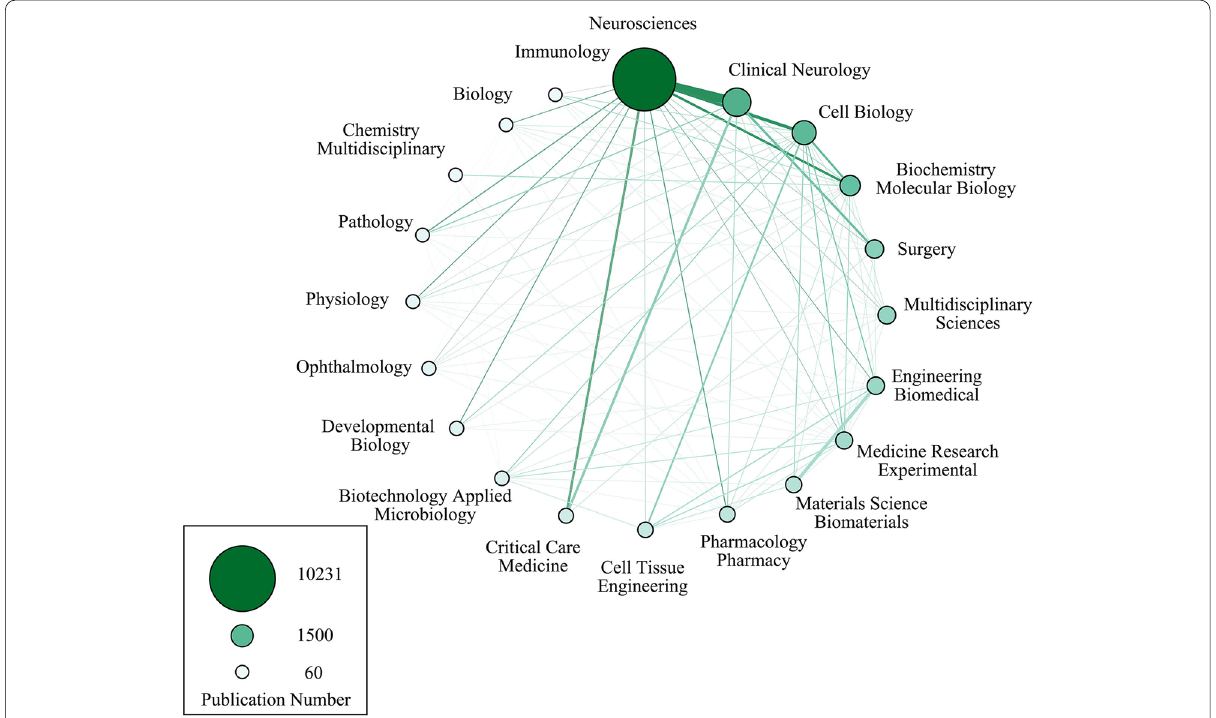
Fig. 6 Cooperation among the top 20 most research field